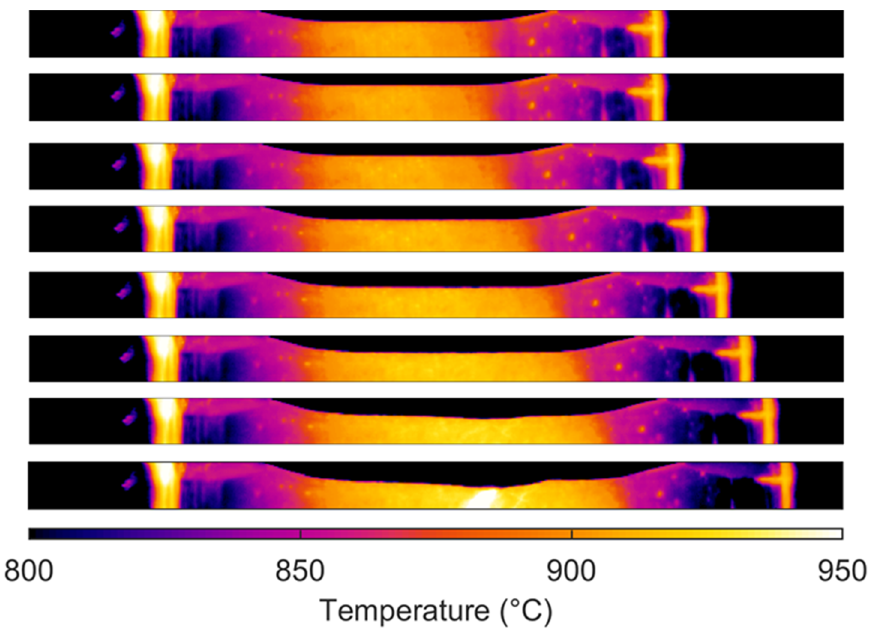
Figure 13. Thermal images acquired by the infrared camera during a high strain rate test at 900 °C: image resolution, 640 × 36 pixels; frame rate, 10,000 fps; integration time, 6.1 μ s.